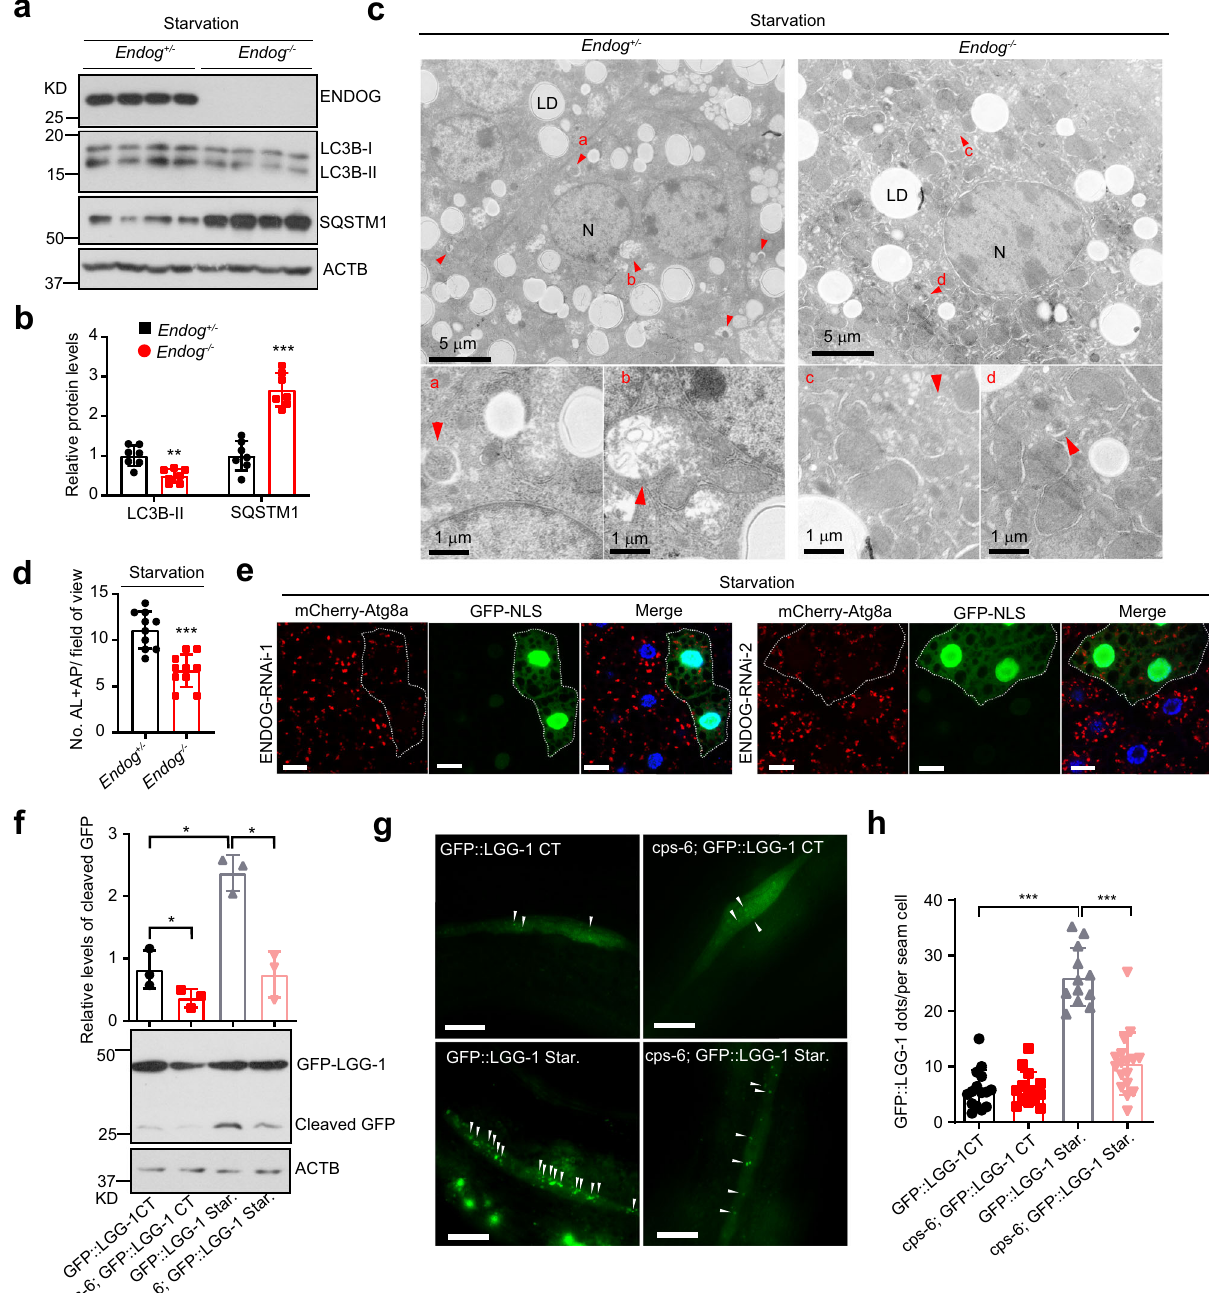
Fig. 2 Loss of ENDOG represses starvation-induced autophagy in different species. a , b . Western blots and quanti fi cation of LC3B and SQSTM1 in Endog + / − or Endog − / − mouse livers after starvation for 24 h ( n = 7 biologically independent animals; data are presented as mean values ± SD; ** p < 0.01, *** p < 0.001). c , d Representative ele c tron microscopic images and quanti fi cation of autophagic vesicles in Endog + / − or Endog − / − mouse livers after starvation for 24 h (LD: lipid drop; N: nuclear; red arrow: autophagic vesicle; n = 10 independent fi elds, data are presented as mean values ± SD, *** p < 0.001). e Representative images show that ENDOG knockdown decreased autophagosome accumulation (mCherry-Atg8a puncta) in Drosophila fat body cells after starvation for 4 h (GFP-NLS-labeled cells circled by dotted line express RNAi targeting ENDOG. Cells outside the circled dotted line are wild-type and used as controls; scale bar = 10 μ m). f Representative western blots of GFP-LGG-1 and ACTB in control (GFP::LGG-1) and ENDOG loss function mutant ( cps-6 ; GFP::LGG-1) C. elegans after starvation for 4 h. Graph, quanti fi cation of cleaved-GFP (correspond to a product of degradation in autolysosomes) ( n = 3 biologically independent experiments, data are presented as mean values ± SD, * p < 0.05). g , h Representative images ( g ) and quanti fi cation ( h ) of GFP-LGG-1 puncta per seam cell in C. elegans (white arrows: GFP-LGG-1 puncta; n = 10 – 15 biologically independent C. elegans , scale bar = 10 μ m; data are presented as mean values ± SD, *** p < 0.001). Source data are provided as a Source data fi